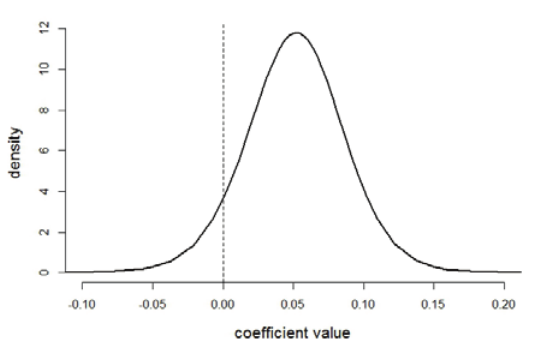
Figure 7. Distribution of coeffi cient values for the 3-year bond interest rate